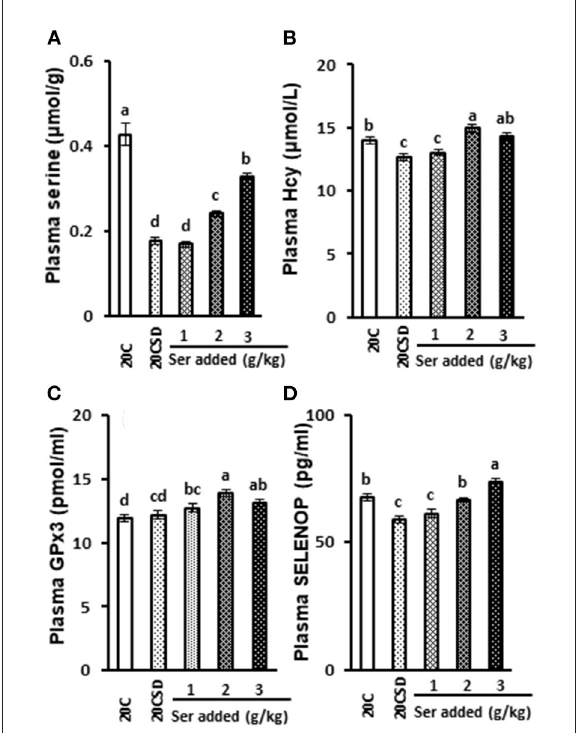
FIGURE2 Effects of supplementation of serine-deprived diet with serine (0.5, 1.0, and 2.0 times the amount of serine in 20C) on plasma concentrations of serine (A) , Hcy (B) , GPx3 (C) and SELENOP (D) in rats fed 20% casein diets (experiment 1). Each value is the mean ± SEM, n = 8. Means in a panel without a common letter differ, P < 0.05. 1, 20% casein (20C); 2, serine-deprived 20C (20CSD); 3, 20CSD + 0.5 × Ser; 4, 20CSD + 1.0 × Ser; 5, 20CSD + 2.0 × Ser.Ser, serine; Hcy, homocysteine; SELENOP, selenoprotein P; GPx3, Glutathione peroxidase